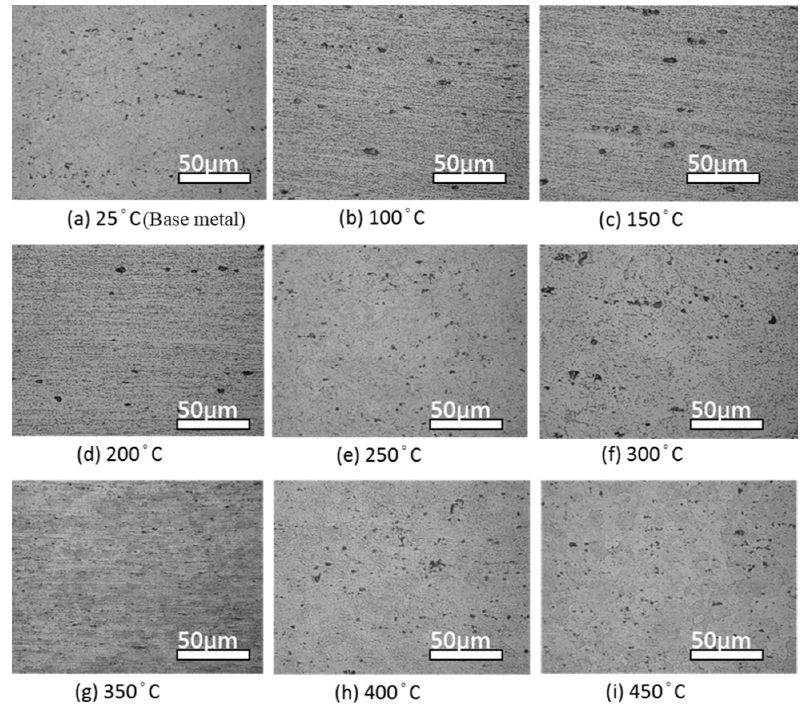
Figure 2. OM images of 5383-H116 Al-Mg alloy β -phase precipitation at different annealing temperatures. ( a ) 25 °C; ( b ) 100 °C; ( c ) 150 °C; ( d ) 200 °C; ( e ) 250 °C; ( f ) 300 °C; ( g ) 350 °C; ( h ) 400 °C; ( i ) 450 °C.